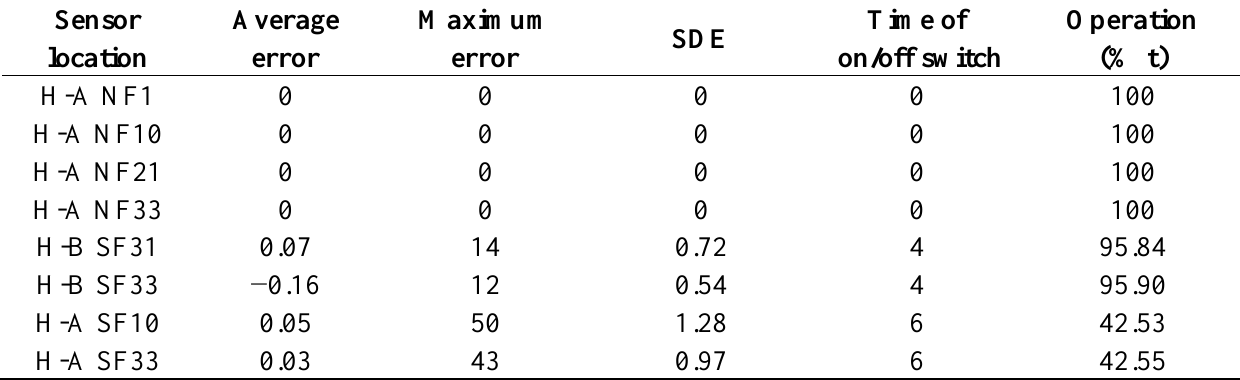
Table 2. Measurement error comparison of vibration sensors with FRS